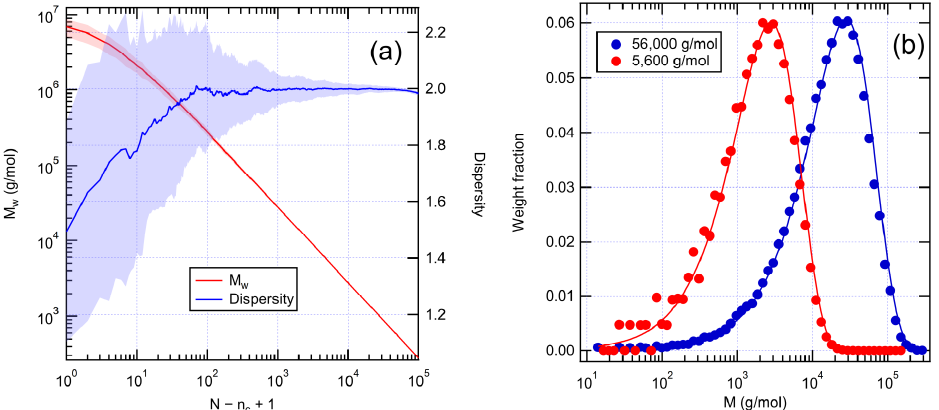
Figure 2. ( a ) Weight average molecular weight and dispersity of the system as a function of the number of random bond scissions applied to an initial single chain consisting of 10 6 monomers. The results are averaged over 100 runs. Shading represents standard deviation. ( b ) Initial molecular weight distributions as averages over 100 runs. Solid lines are Flory–Schulz distributions for 0.05% (56,000 g/mol) and 0.5% (5600 g/mol) of initial bonds scissed.